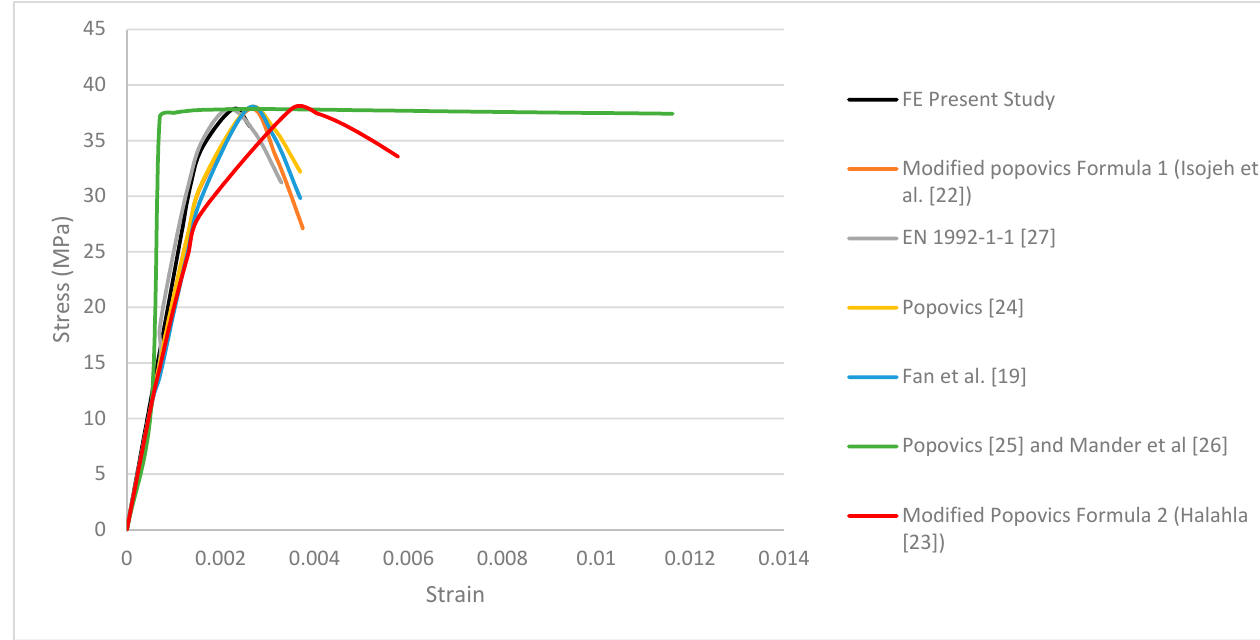
Figure 2. Comparison of stress–strain relations and FE presented in this study for a concrete cube including 20% FA with the proposed equation of Ec = 3510(cid:3493)𝑓′ (cid:3030) for modified Popovics models.